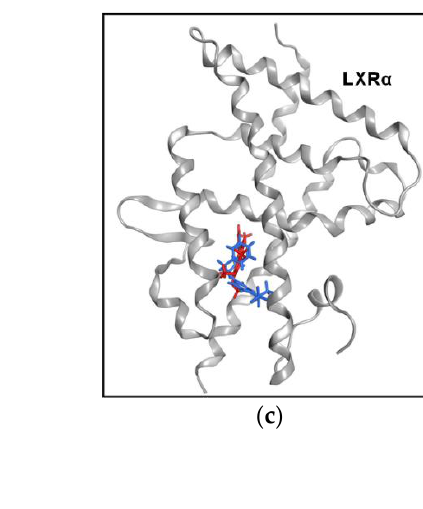
Tangeretin T0901317 Figure 9. Cont